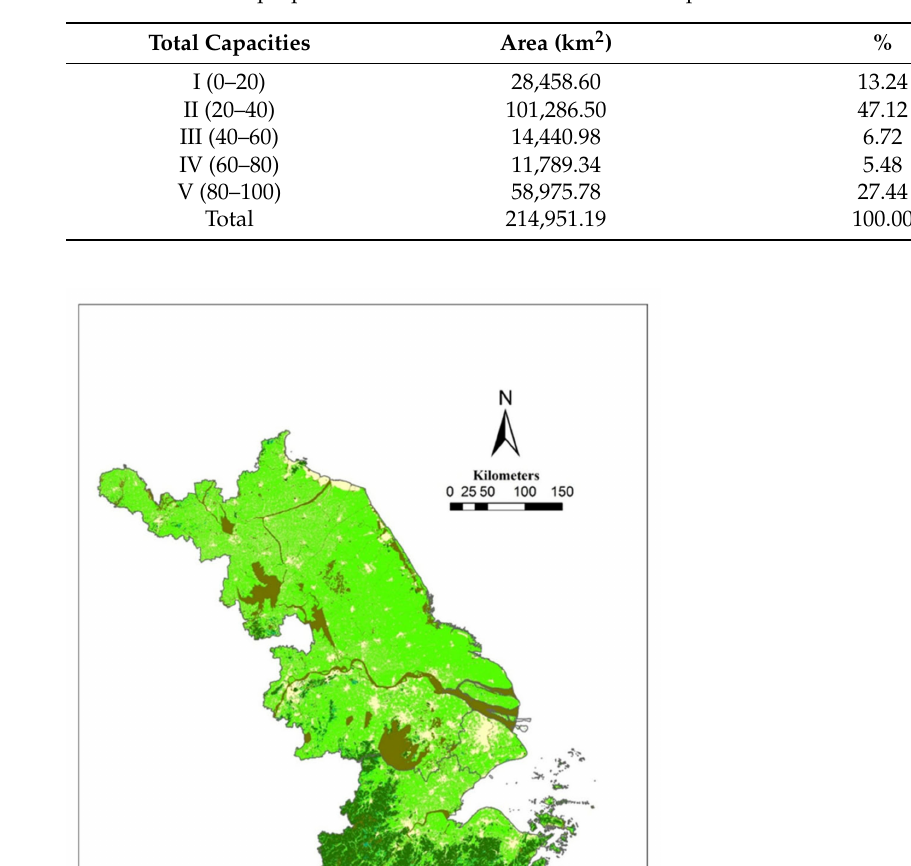
Table 2. Areas and proportions of different levels of total ES capacities.